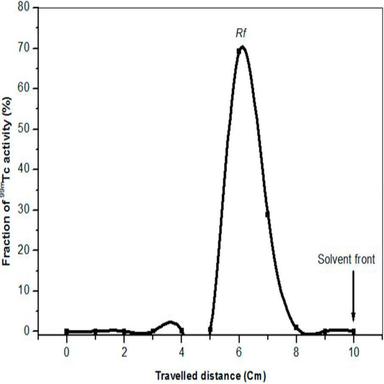
Radiochromatogram of the eluted 99mTc from mesoporous ( 99Mo–MnO2/MWCNT) generator.